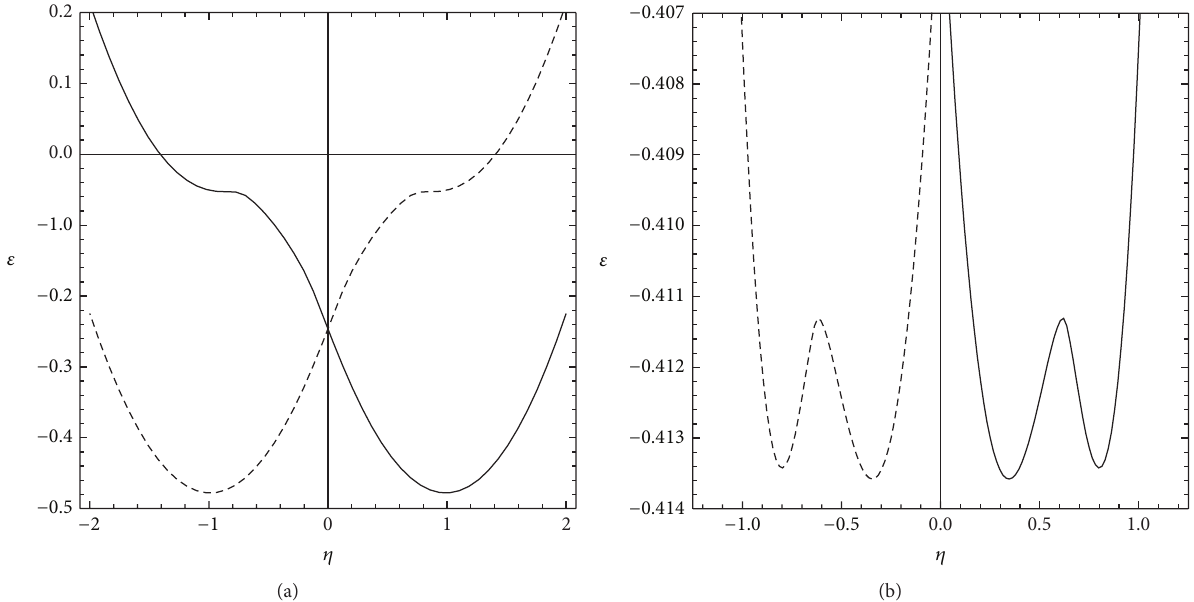
Figure 2: The mean field effective energy per site 𝜀 versus 𝜂 for different values of 𝐻 and 𝐷 , 𝐽 = 1 , symmetric solutions . (a) 𝐷 = 0.3 ; full line: = 0.22 obtained for the “up” part of the single loop hysteresis cycle; dashed line: 𝐻 𝐻 = 𝐻 𝑐 Note that the physically sensible regime of 𝜂 is restricted to the interval [−1,1] . (b) 𝐷 = 0.8 ; full line: 𝐻 = 0.09 obtained for the “up” part of the double loop hysteresis cycle; dashed line: 𝐻 = −0.09 obtained for the “down” part of the cycle.